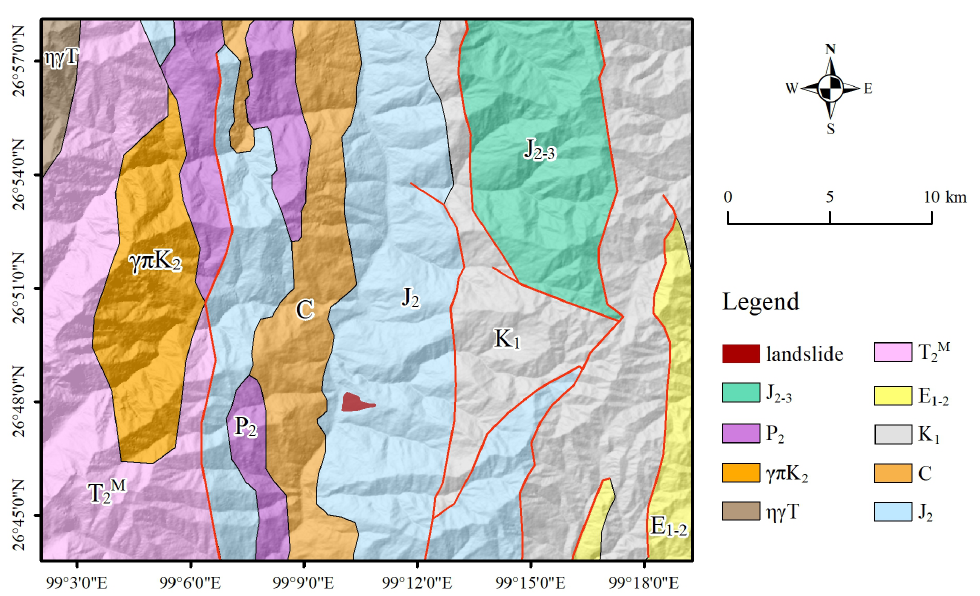
Figure 14. The geological map of the study